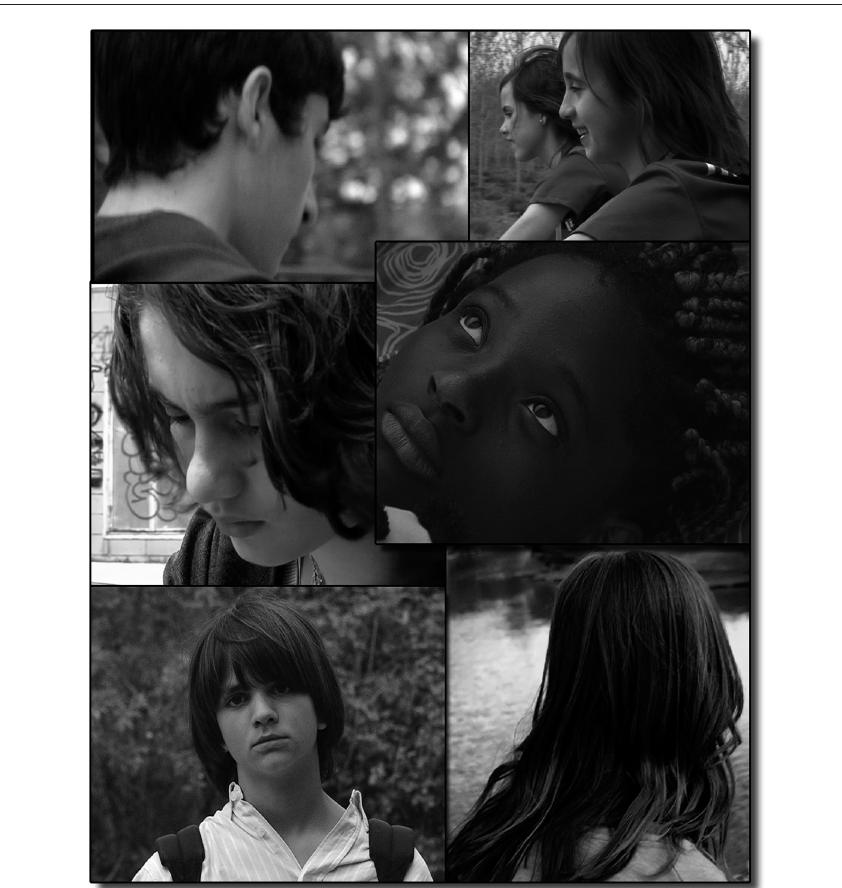
figure 2: clockwise from the top right corner: Camins, silencis i somriures (Paths, silences and smiles, Bordils School); Mirades que escolten (listening looks, mestre morera School, Barcelona); Temps a venir (times to come, castellet institute, Sant Vicenç de castellet); Ciutat estranya (Strange city, júlia minguell institute, Badalona); Escapada (escapade, els Xiprers School, Barcelona); L’última festa (the last party, castell d’estela institute, amer) (source: